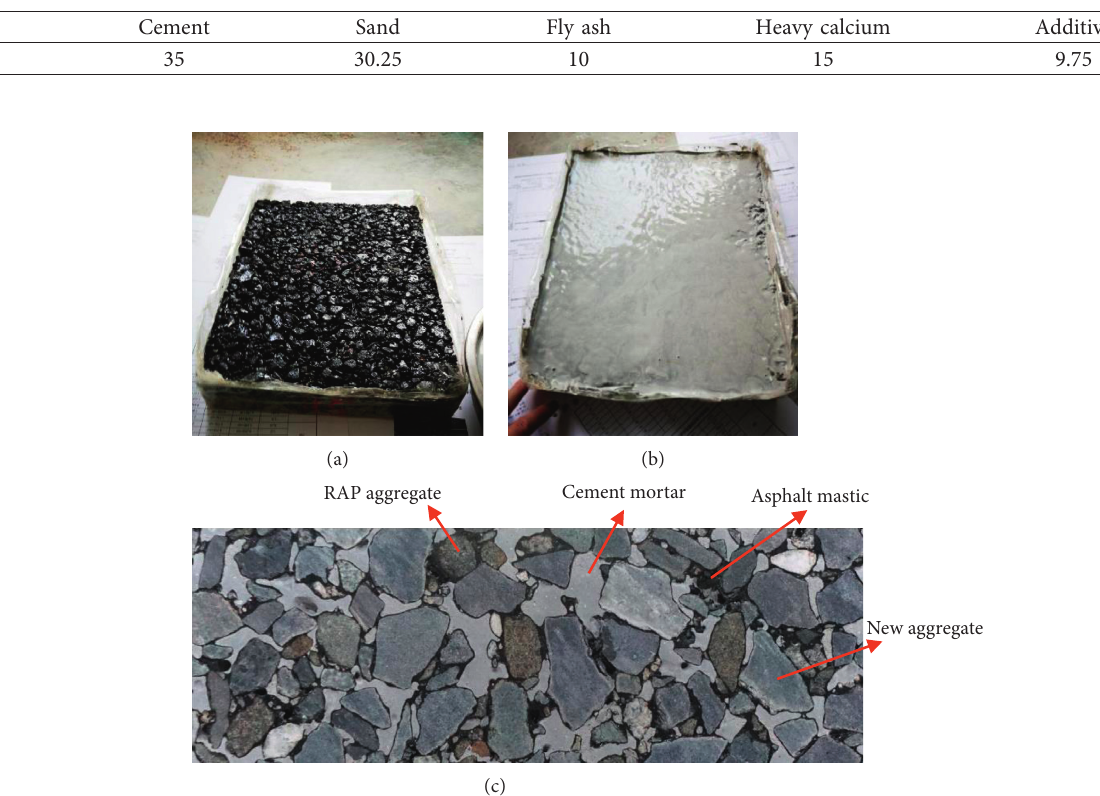
Table 4: Gradation of dry powder mortar.